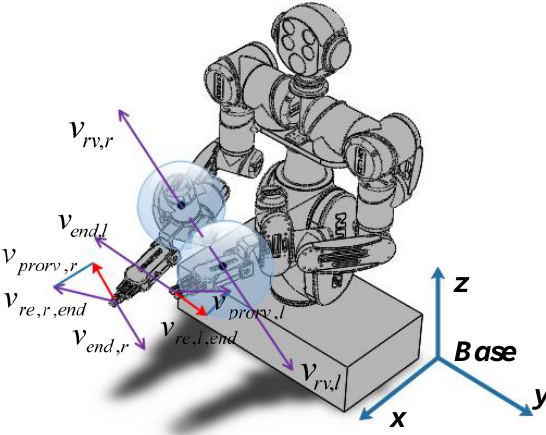
Figure 6. Two redundant arms work in 3D space.